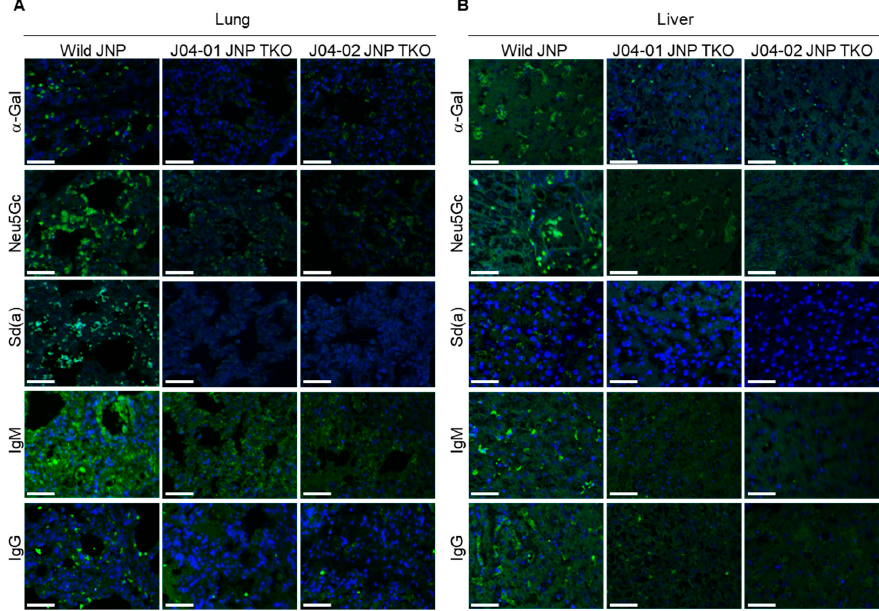
Figure 5. Expressions of α‐ Gal, Neu5Gc, and Sd(a) along with human IgM and IgG antibody binding assays in the lungs and liver of wild ‐ type and TKO JNPs. Immunofluorescence analysis of α‐ Gal, Neu5Gc, and Sd(a) was performed using wild ‐ type and TKO JNP lung ( A ) and liver ( B ) tissues. In addition, human IgM and IgG binding assay was performed in the lung and liver tissues. Represented images were overlaid with blue (DAPI) for nucleus and green (Alexa Fluor 488) for target proteins ( α -Gal, Neu5Gc, and Sd(a)). Scale bar = 30 µ